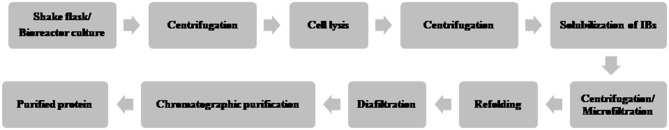
Flow chart of the purification of recombinant proteins expressed as IBs using E. coli.